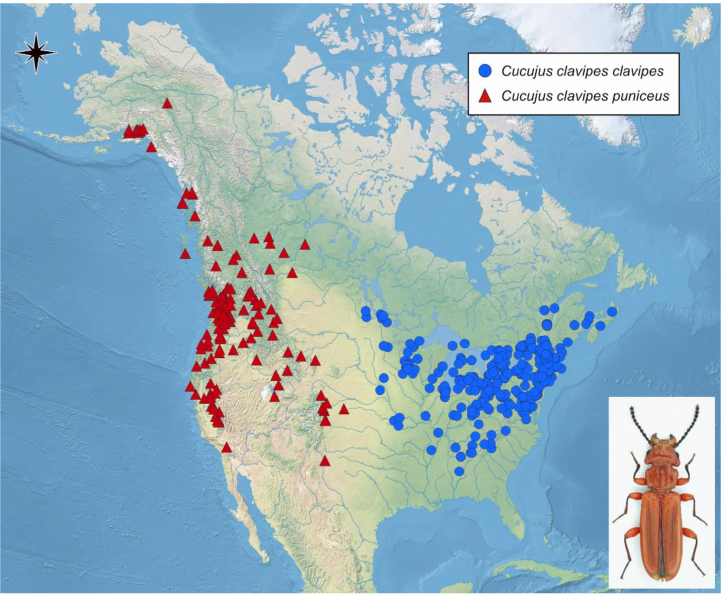
Figure 1. Location of Cucujus clavipes records based on observation by citizen scientists published on iNaturalist.org and used in this study (picture shows spp. clavipes; phot. M. Michalski. To analyze macrohabitat preferences of the Cucujus clavipes subspecies, the Global Land Cover by National Mapping Organizations ver. 3 (GLCNMO; https://globalmaps. github.io/glcnmo.html, accessed on 10 December 2020) was